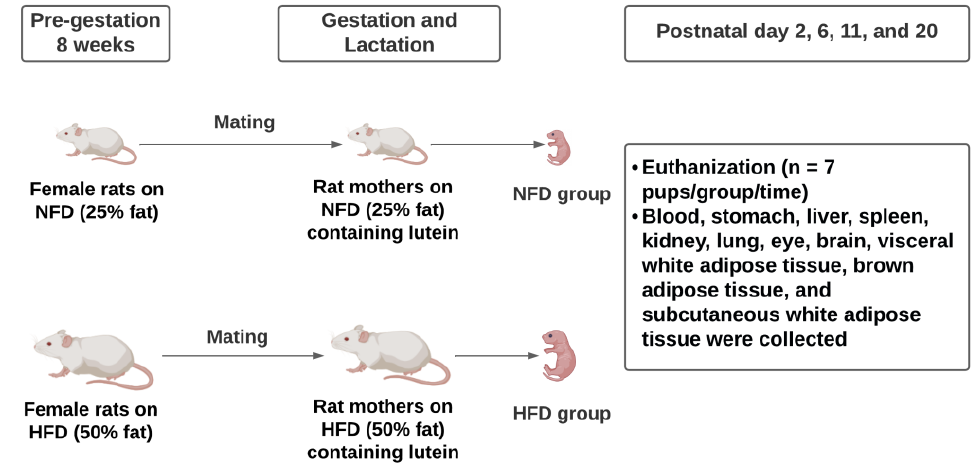
Figure 1. Schematic diagram of study